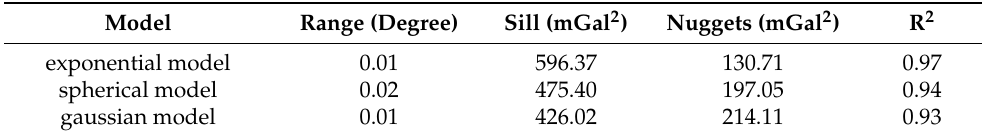
Figure 4. Variogram value distribution and fitting results in vertical direction. Table 2. Three theoretical variograms are used to fit the experimental variograms in vertical